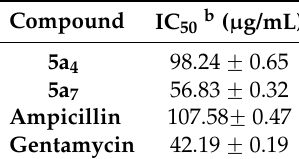
Table 3. IC 50 ( µ g/mL) values of the compounds against mouse macrophage cell lines (RAW 264.7 a